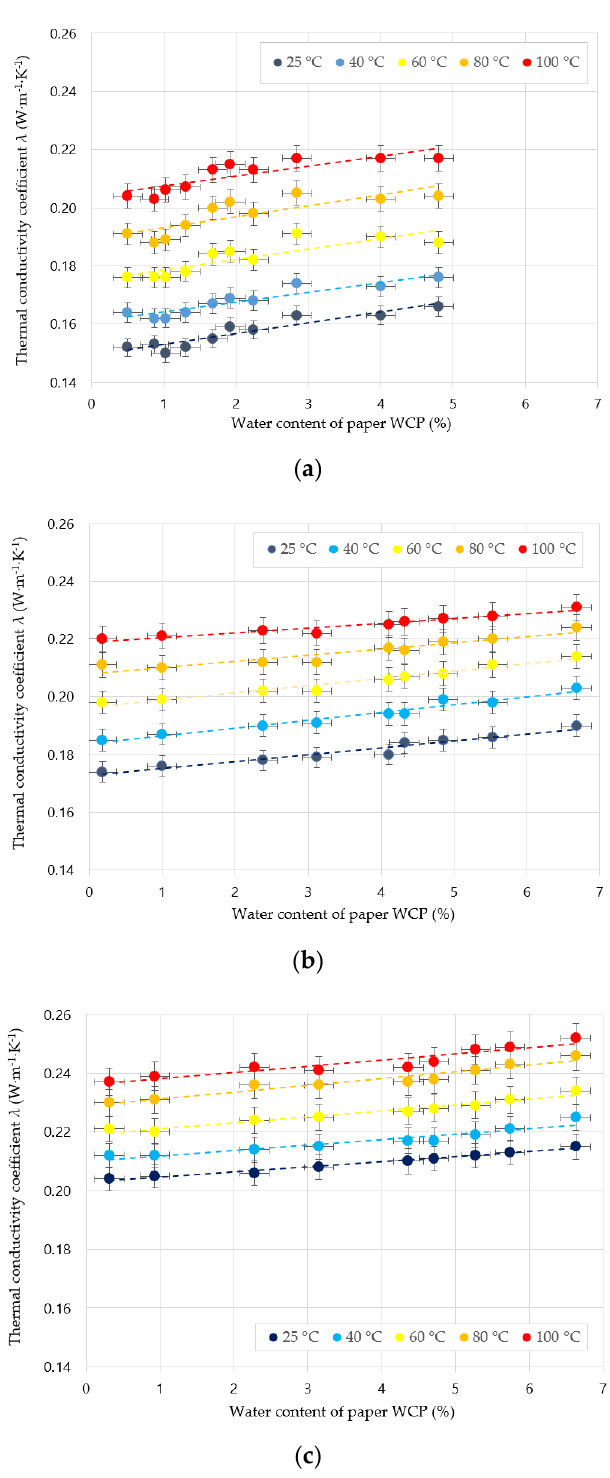
Figure 2. Thermal conductivity coefficient λ of cellulose paper impregnated by various dielectric liquids depending on the water content of paper WCP and temperature T : ( a ) cellulose paper impregnated by mineral oil; ( b ) cellulose paper impregnated by synthetic ester; ( c ) cellulose paper impregnated by natural ester.